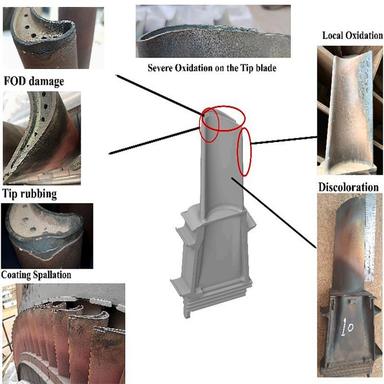
Damage mechanisms of the first stage blades after long time exposure (exposure time 75,000 h).